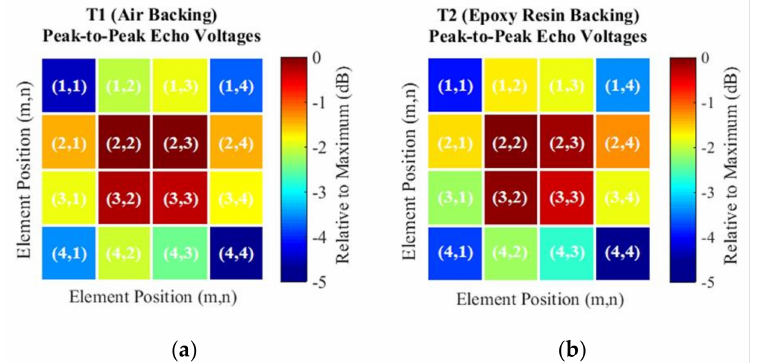
Figure 16. The echo responses of ( a ) the transducer T1 and ( b ) transducer T2 present an apodiza- tion effect, where the peripheral elements that are connected to the foam housing (soft material) present amplitudes lower than those of the central elements, surrounded by piezoelectric elements (hard